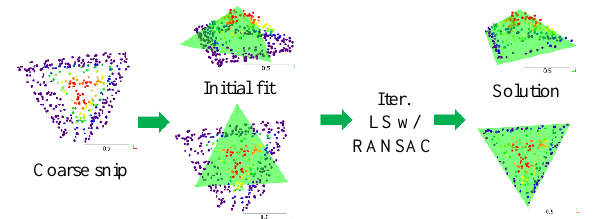
Figure 4. Overview of the pyramid template fitting